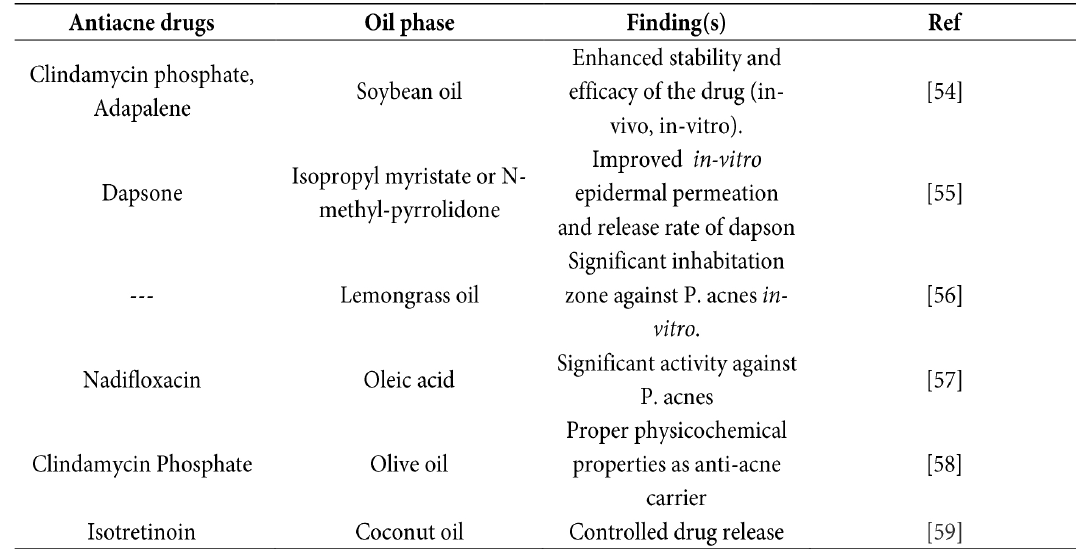
Table 2. Examples of nanoemulsions for acne